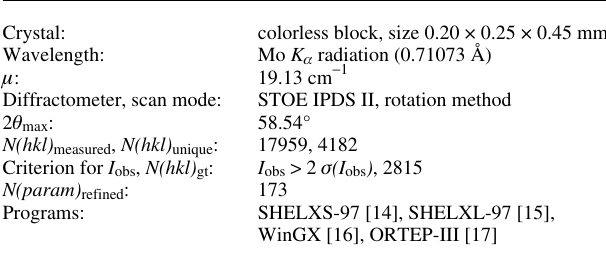
Table 1. Data collection and handling.